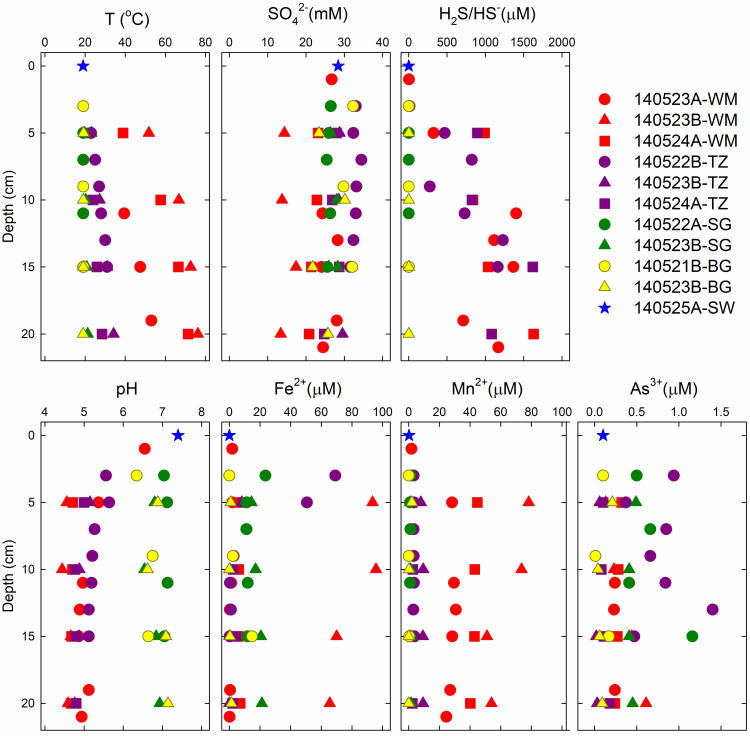
Geochemical profiles of temperature, pH, and selected ions.Red symbols refer to white mat (WM), purple to transition zone (TZ), green to seagrass (SG), yellow to background (BG) and blue to surface seawater (SW). Different symbols of the same color indicate different date/time of the sampling dives.